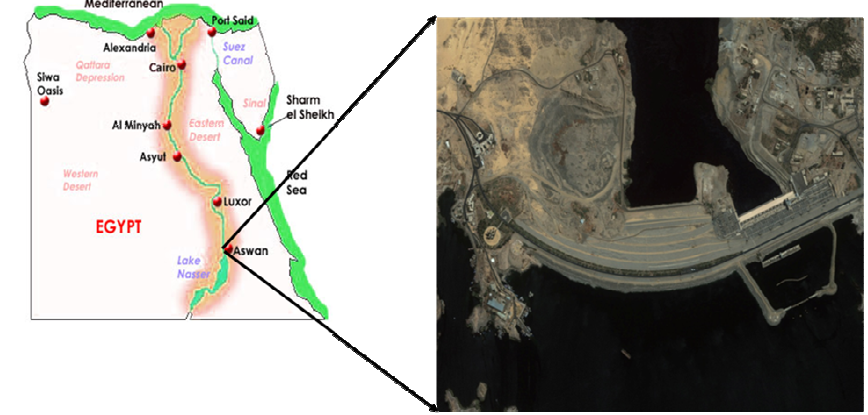
Fig. (1). Location of Aswan High Dam Fig. 1. Location of Aswan High